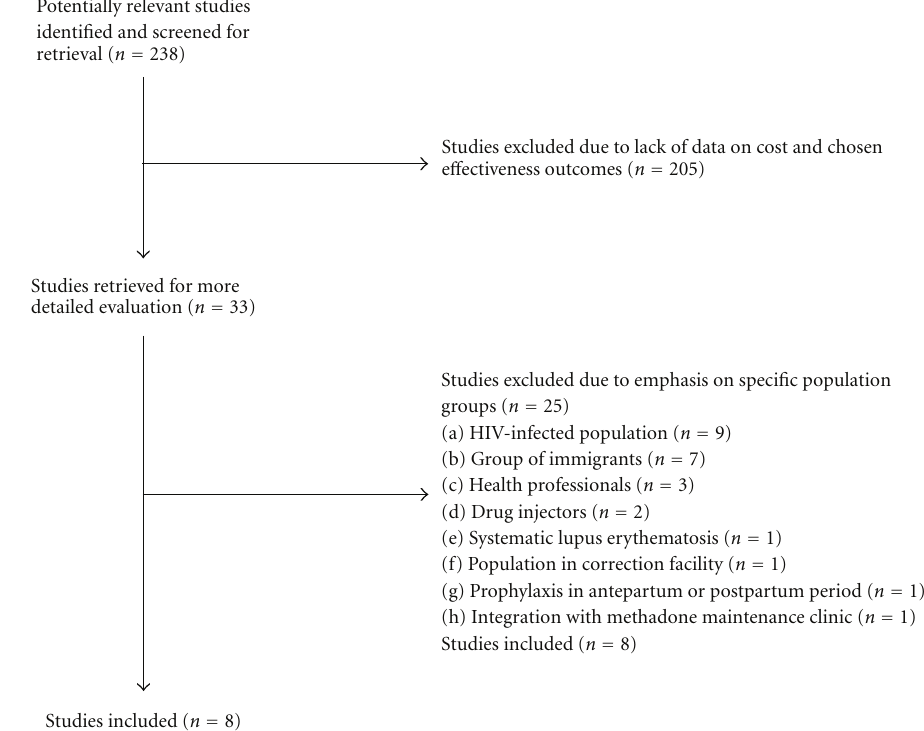
Figure 1: Flow chart of study selection